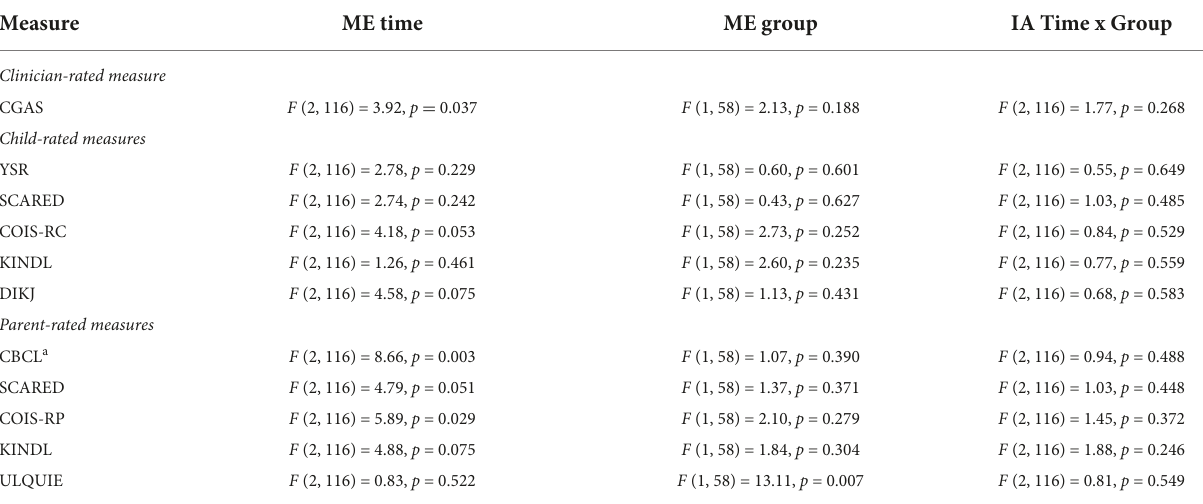
TABLE 5 Statistical analyses of secondary outcome measures—stability of effects. Mixed two-way ANOVA with the factors group (treatment, waiting list) and time (post-treatment, follow-up I, follow-up